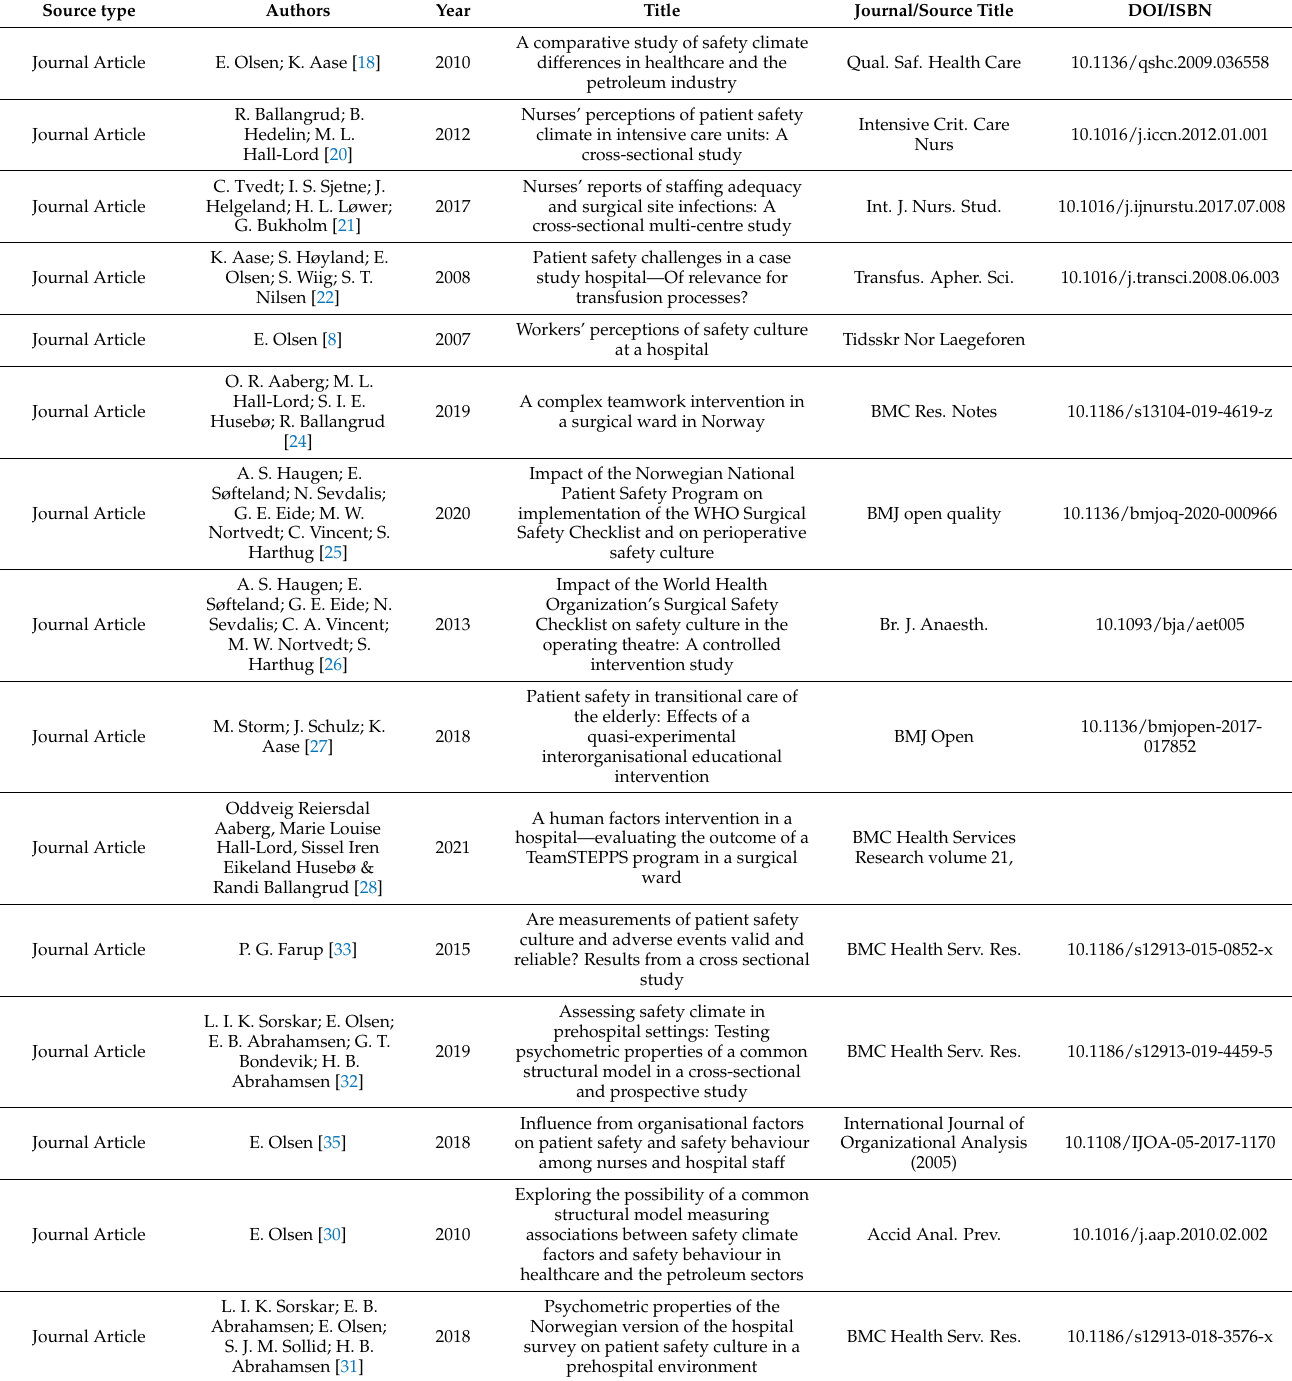
Table A1. Overview of 20 studies included in this